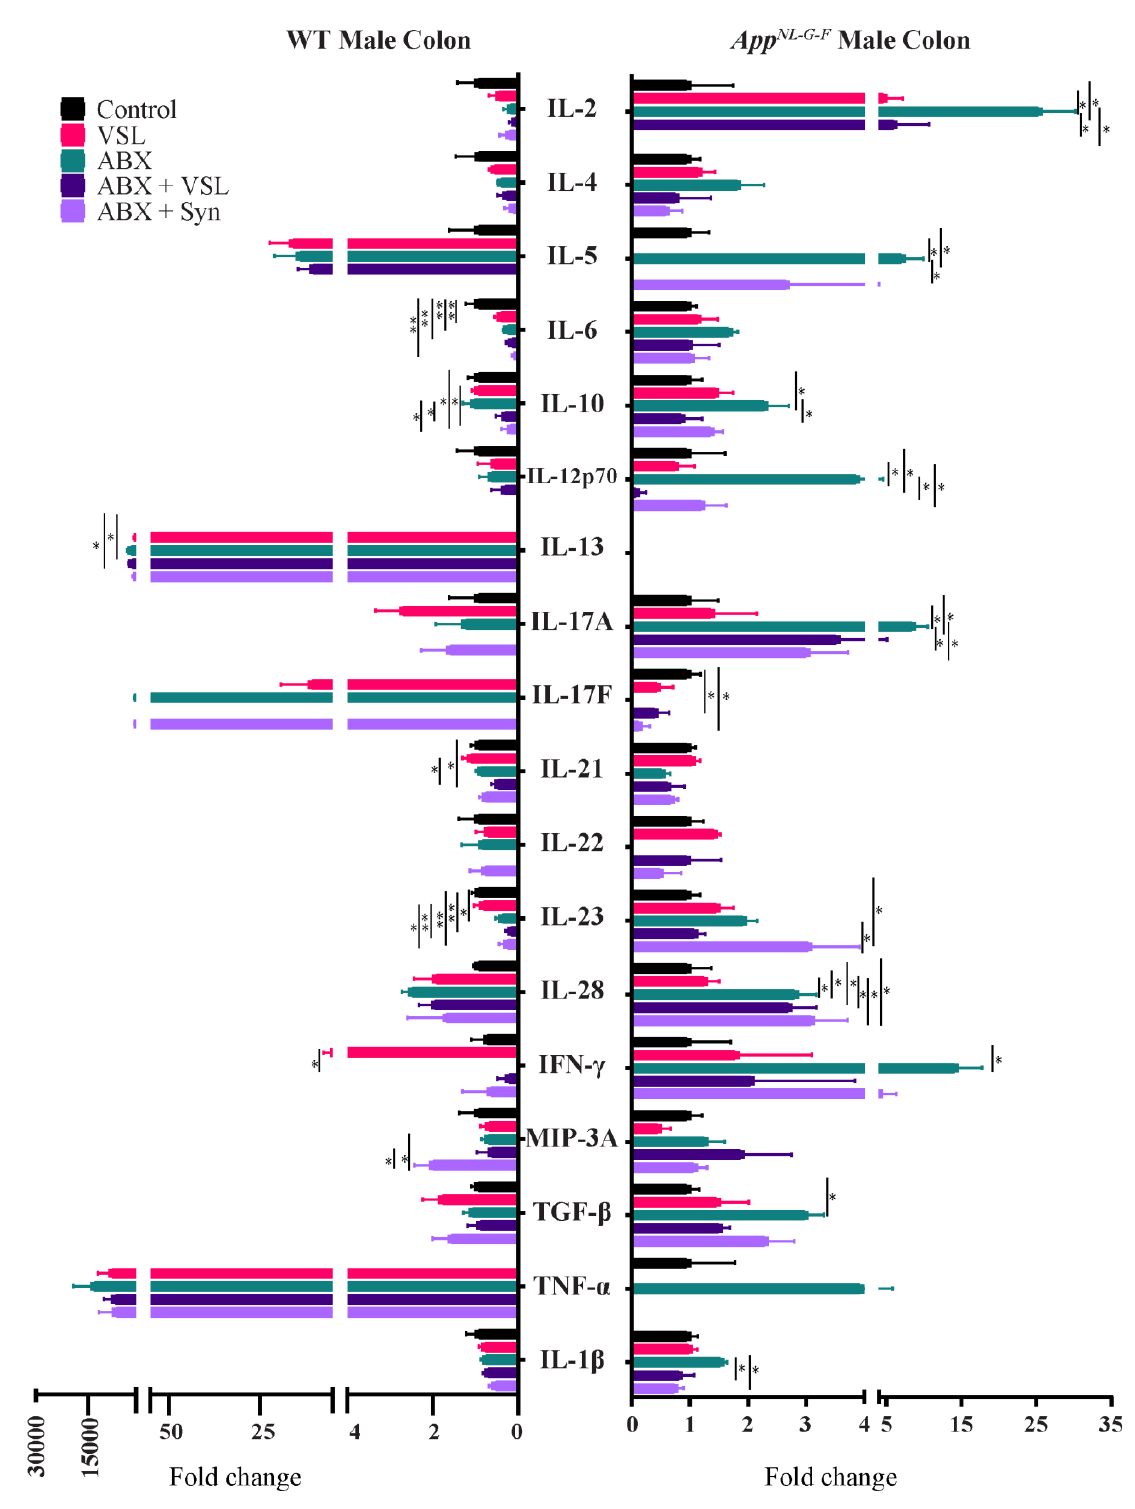
Figure 8. Quantification of colon levels of Th1, Th2, and Th17 cytokines in male C57BL/6J (WT) and App NL-G-F mice. Colons were lysed from vehicle, VSL#3, antibiotics (ABX), antibiotics+VSL#3 (ABX+VSL), and antibiotics+VSL#3+prebiotic (ABX + Syn) male WT mice to quantify cytokine levels via commercial slide array. Data are presented as fold change with respect to controls ( n = 5). If the controls values were zero, we used 0.1 as an arbitrary value for that group to calculate the fold change in that dataset. Significant differences were determined by a one-way analysis of variance, * p < 0.05, ** p <